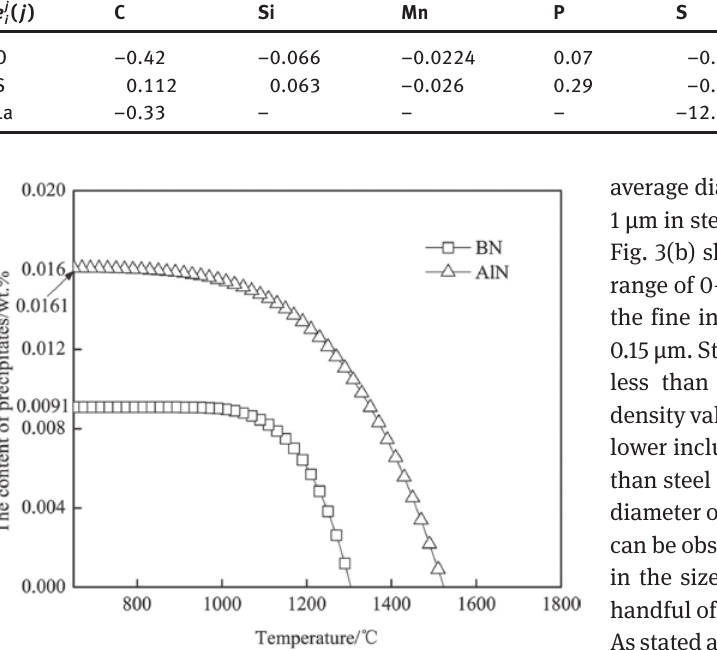
Fig. 2: The relationships between the content of BN, AlN precipitates and